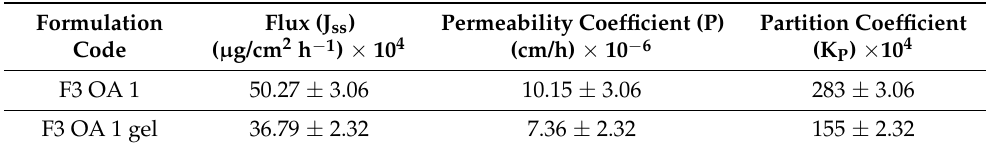
Table 4. Ex vivo permeation parameters of TCR from selected SPLs (F3 OA 1) and F3 OA 1 gel formula ( n = 3, mean ±